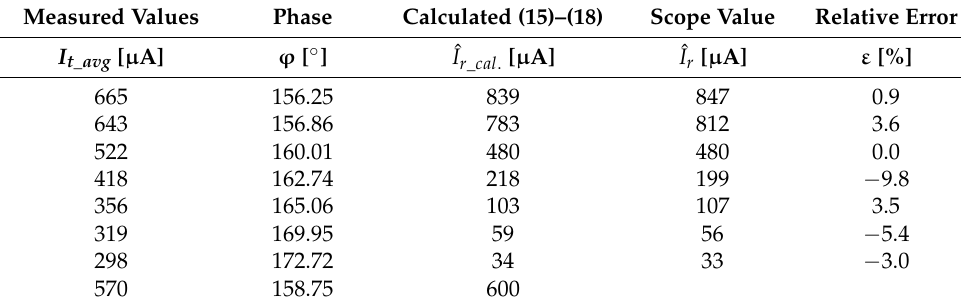
Table 4. Verification of measurement